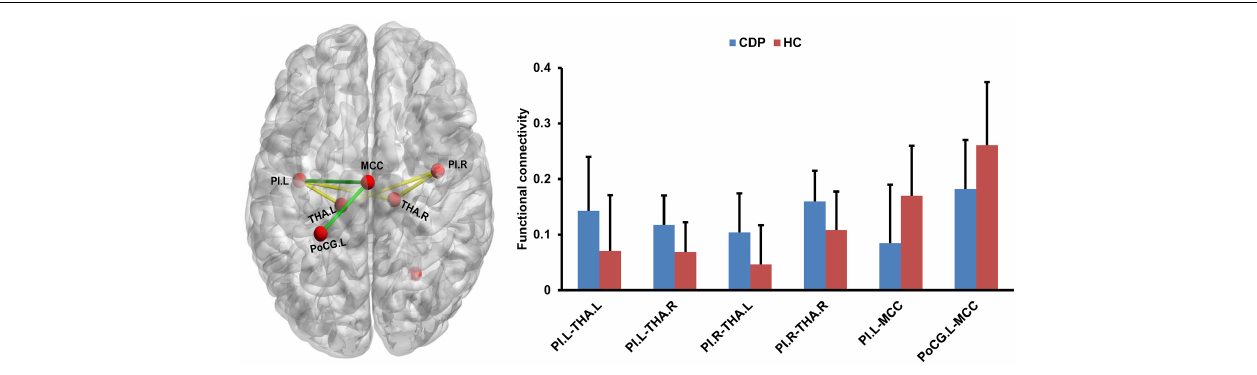
FIGURE 4 | Changed resting-state functional connectivities within pain network. CDP patients exhibited increased functional connectivities between bilateral posterior insula (PI) and bilateral thalamus (THA.L and THA.R) compared to healthy controls. Moreover, decreased functional connectivities between the middle cingulate cortex (MCC) and left postcentral gyrus (PoCG.L), left PI were also found in CDP